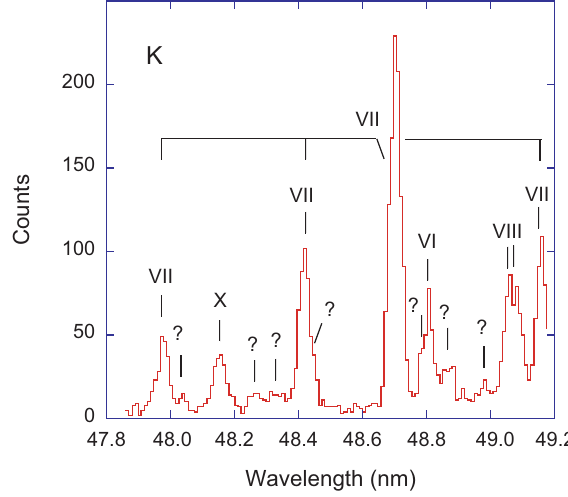
Figure 7. Detail spectrum of K at an ion beam energy of 5MeV. Line width 0.045nm. Identified spectral features are marked by the spectrum number. The KVII transition array marked is discussed in the